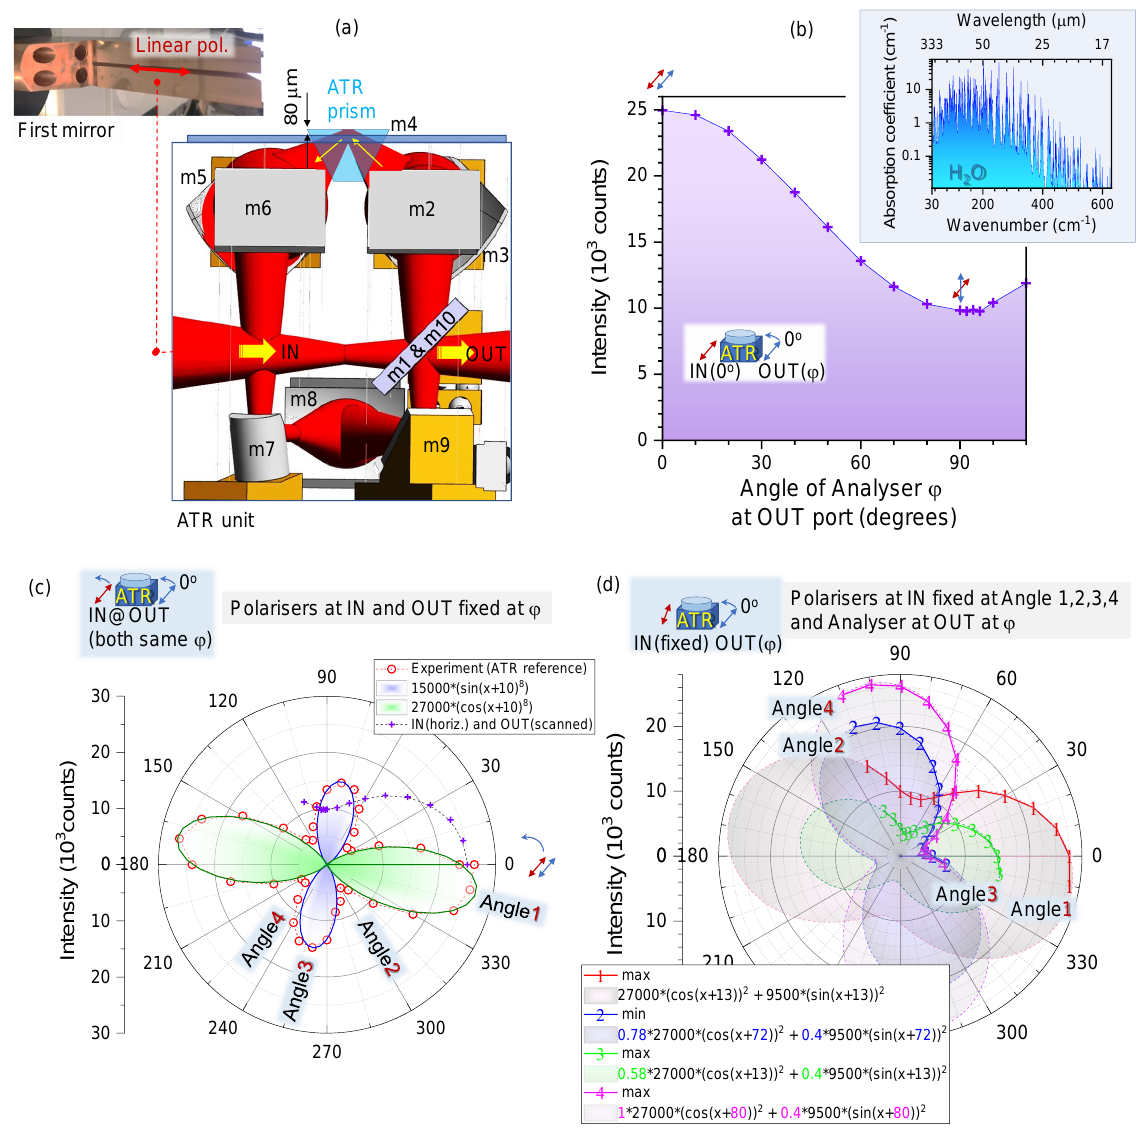
Figure 7. ( a ) Schematic of the ATR unit (Pike) used in this study. From the port IN to OUT, there are ten reflections (mirrors m1–10). ( b ) Cross-polarised performance of the ATR unit. The polarisation is set horizontal ( ϕ = 0 ◦ ) at the IN port. This corresponds to the maximum of linear polarisation of synchrotron radiation extracted by the first mirror (slotted mirror at the bending magnet of the synchrotron). THz spectrum over 30–630 cm − 1 (0.9–18.9 THz) is integrated (spectral range is defined by the mylar beamsplitter, and the detector is a Si bolometer). The water vapour absorption coefficient at 1 atm over the same spectral window [36] is shown in the inset. ( c ) Co-rotation of the mesh-grid polariser and analyser (at the IN and OUT ports): dots are experimental data and fits by E 2 s ∝ cos 8 ( ϕ + ∆ ψ s ) and E 2 p ∝ sin 8 ( ϕ + ∆ ψ p ) intensity components (see text for details). Four angles separated by 45 ◦ degrees are selected, where the local maxima or minima are observed (Angles 1–4). ( d ) Polarisation analysis of signal at port OUT for Angles 1–4 (at the IN port): experimental data by markers 1–4 and fit by Equation (4). The legend shows the fit functions